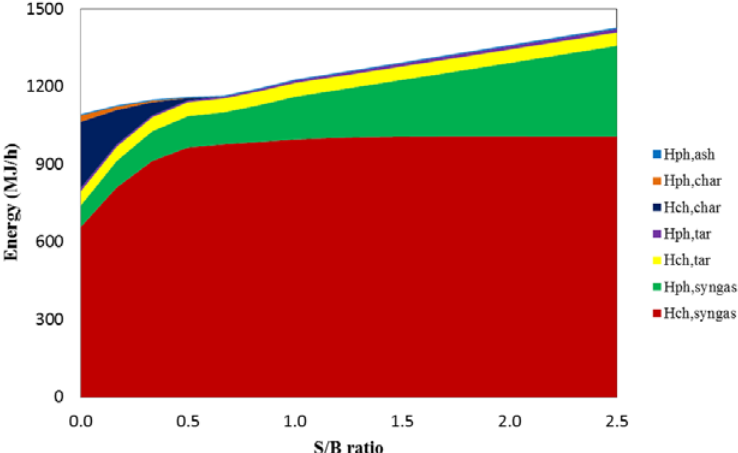
Figure 3. Energy balance of the HTAG process as a function of steam/biomass mass (S/B) ratio for T = 1000